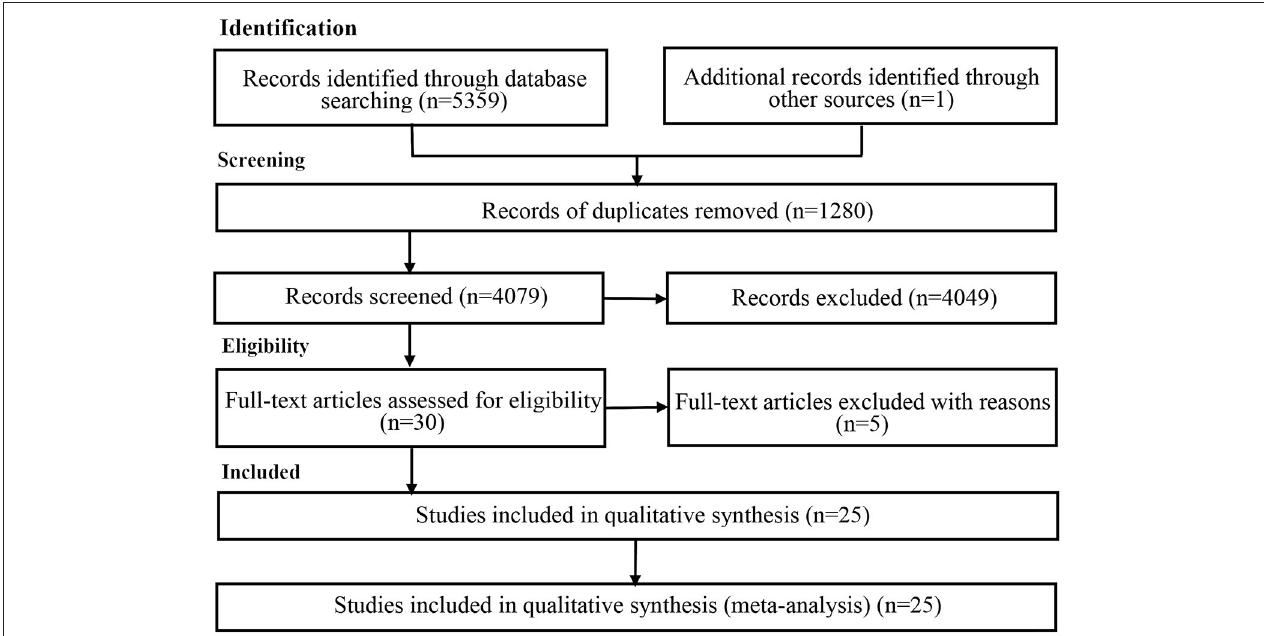
FIGURE 1 | Flow diagram depicting the search protocol and workflow in determining the studies for inclusion in the